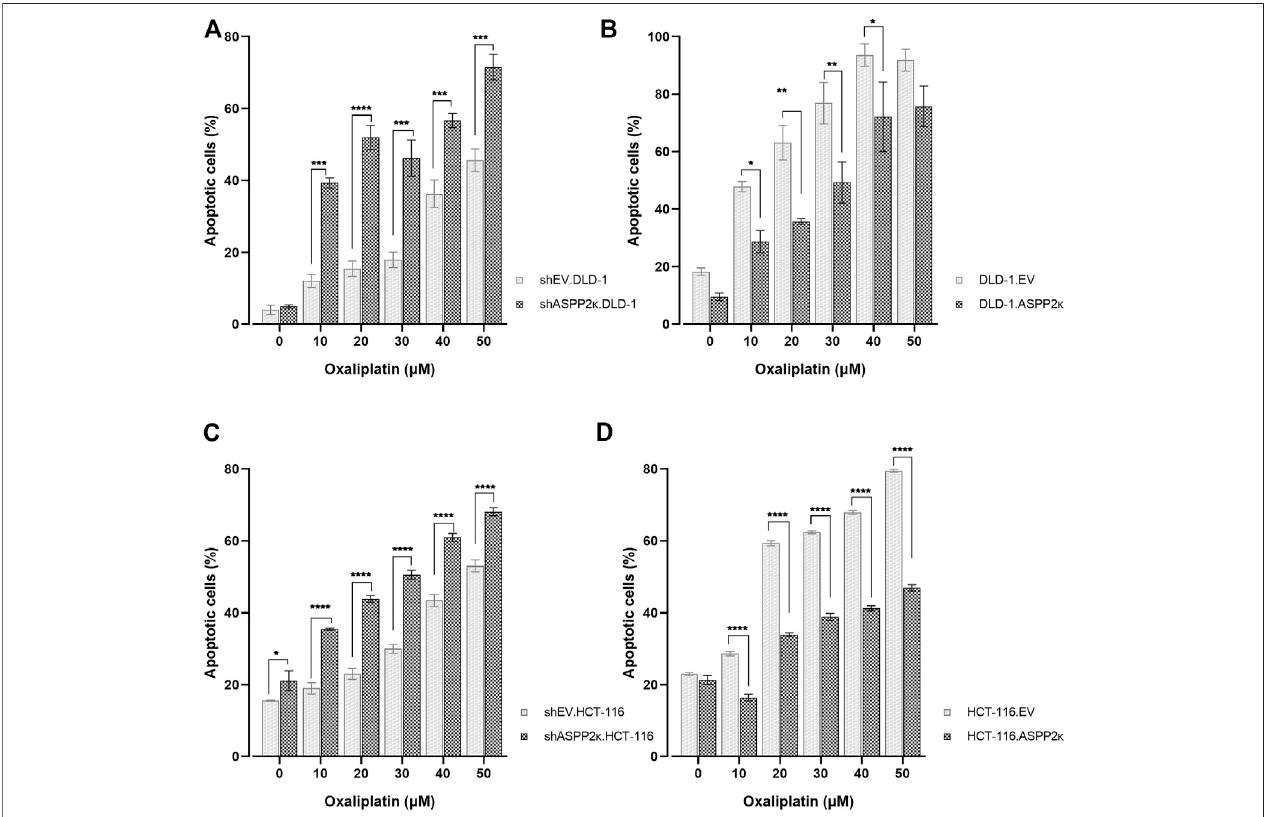
FIGURE 3 | Dose dilution experiments using (A) DLD-1 or (C) HCT116 ASPP2 κ silenced strains (B) DLD-1 or (D) HCT116 ASPP2 κ overexpressing strains are shown.Induction ofapoptosis after exposure ofcell strainstoOxfor48 hisassessed fl owcytometrically usingannexinV/7-AAD.EV,empty vector. Statisticaltest: two- way ANOVA. **** p < 0.0001, *** p < 0.001, ** p < 0.01, * p <